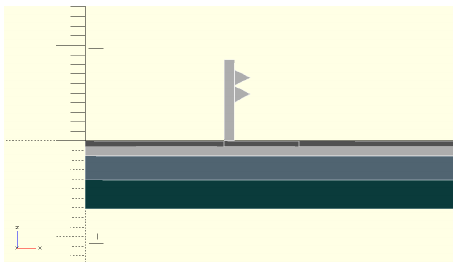
Figure 2. Road layers section with guardrail on the left roadside.